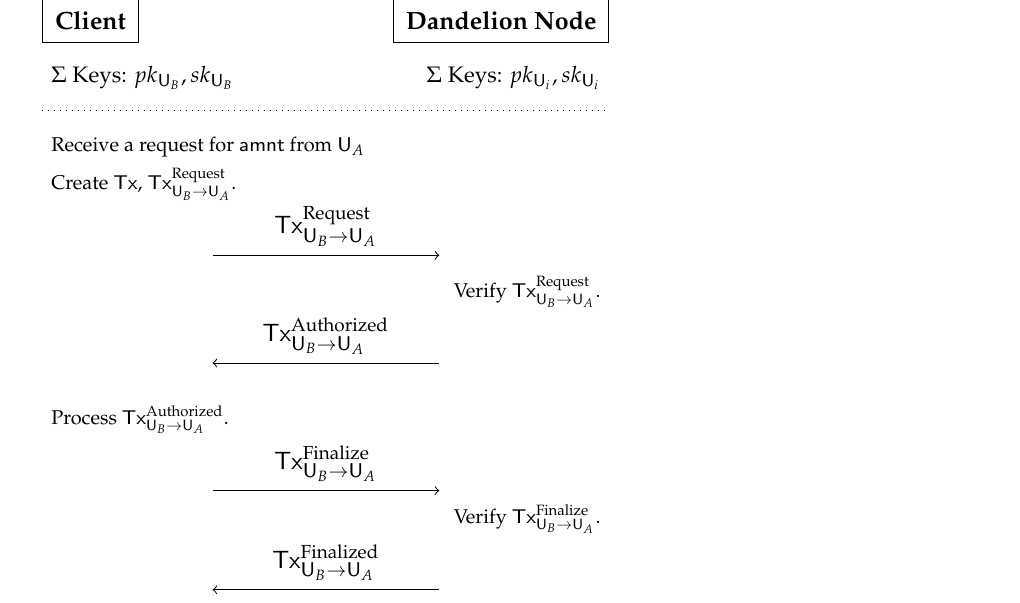
Figure 4. The Dandelion transaction request message flow.